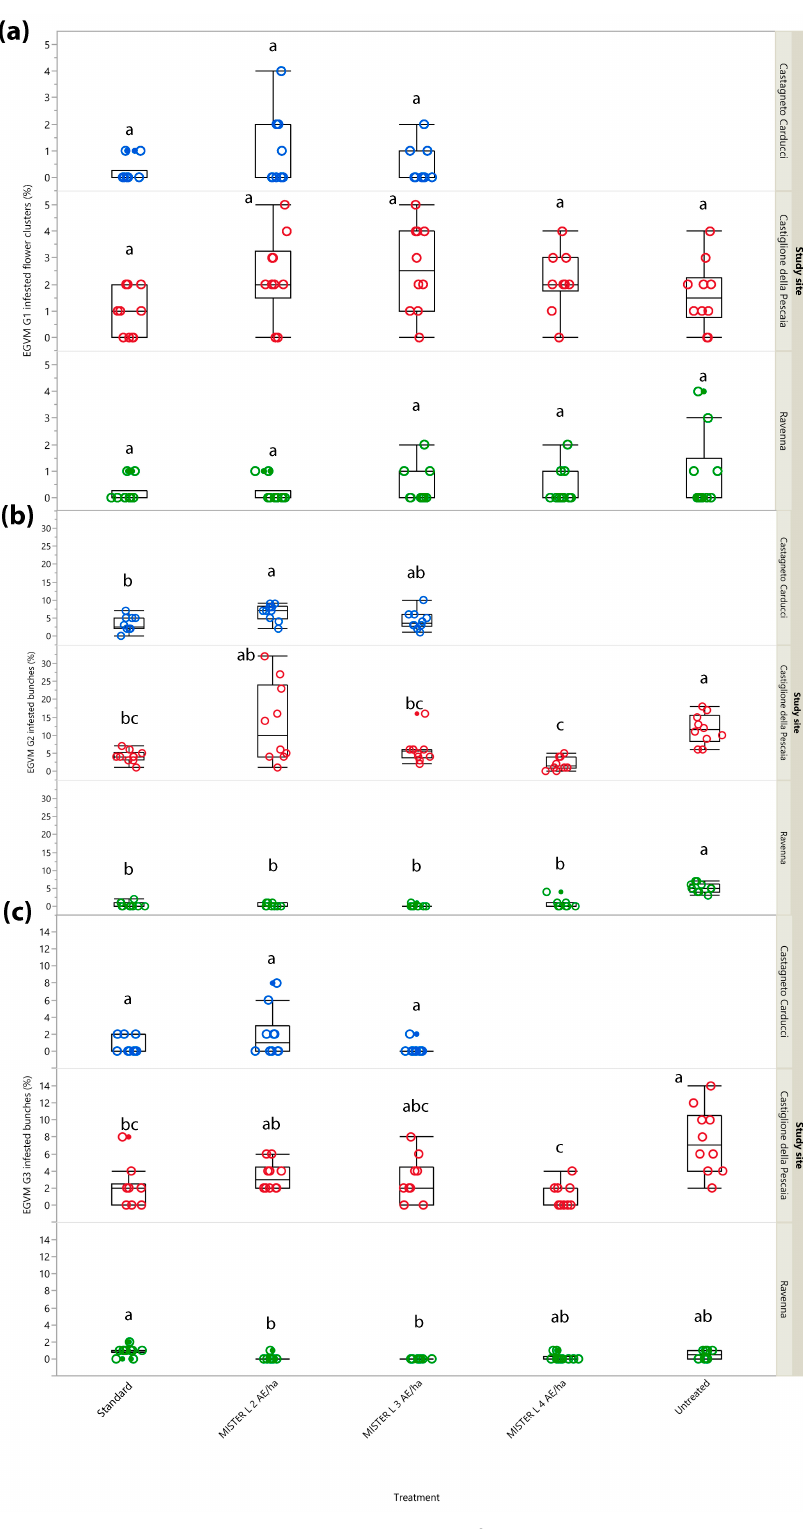
Figure 2. Impact of mating disruption using Isonet ® L MISTERX843 on the percentage of flower clusters (G1) or bunches (G2 and G3) infested by Lobesia botrana (EGVM) in Tuscany (Central Italy, in blue and red) and Emilia-Romagna (Northern Italy, in green) during 2017. Box plots indicate the median (solid line) within each box and the range of dispersion (lower and upper quartiles and outliers) of the infestation parameter. ( a ) G1: first generation; ( b ) G2: second generation; ( c ) G3: third generation (harvest). Within each generation and study site, different letters above box plots indicate significant differences between treatments (Kruskal–Wallis test followed by Steel–Dwass test, p <